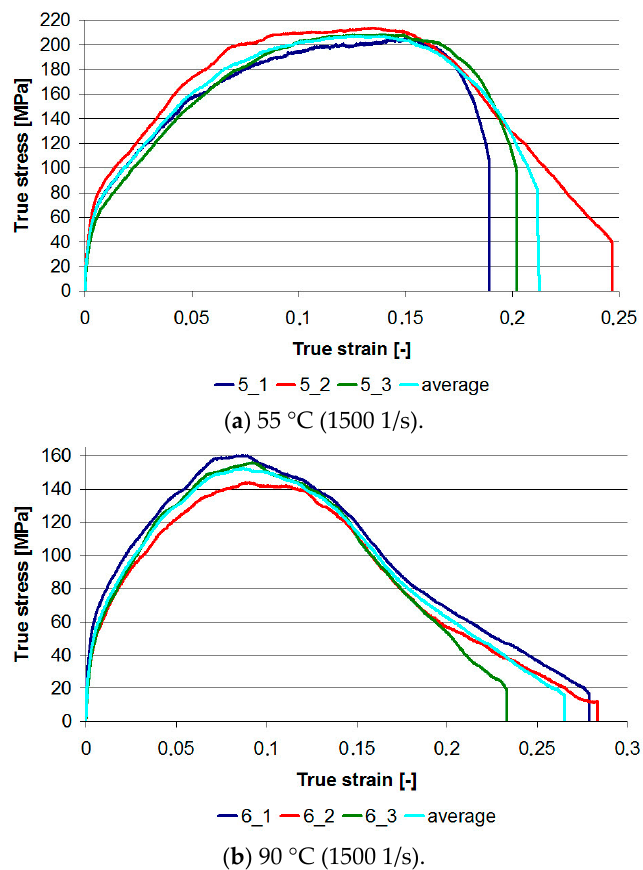
Figure 10. True stress–true strain graphs in dynamic compression tests for two temperatures: ( a ) 55 °C—samples 5_1 to 5_3; ( b ) 90 °C—samples 6_1 to 6_3.